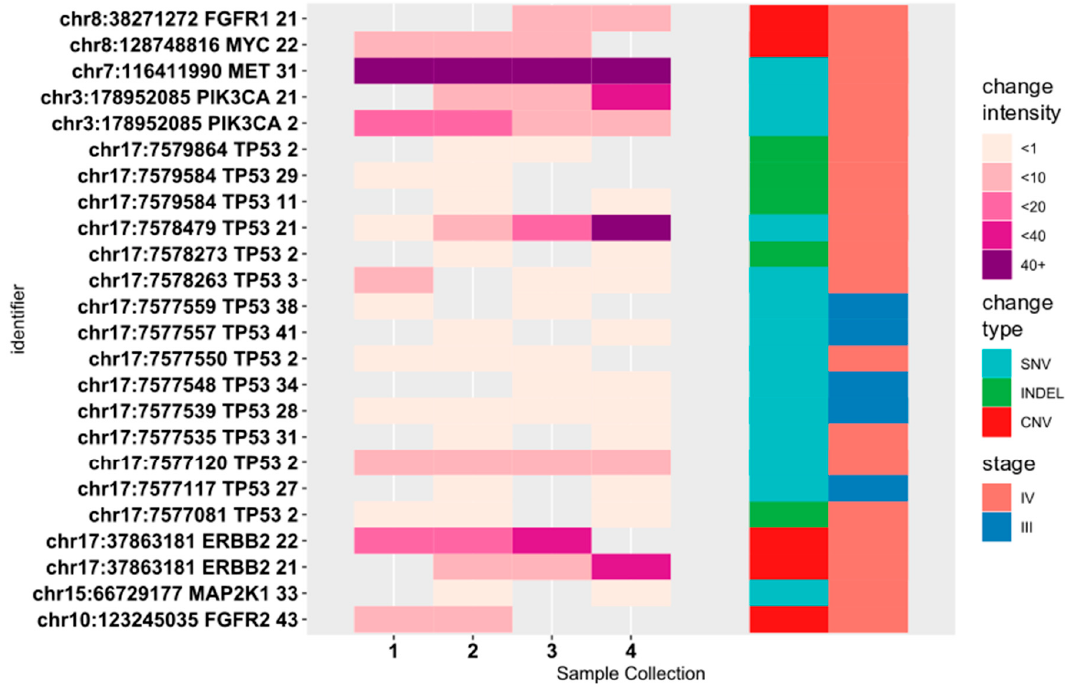
Figure 2. Potentially pathogenic variants found in at least two cfDNA samples from one BC patient. Change intensity is interpreted as allele frequency for SNVs (single nucleotide variant) and indels and as copy number gain for copy number variants.